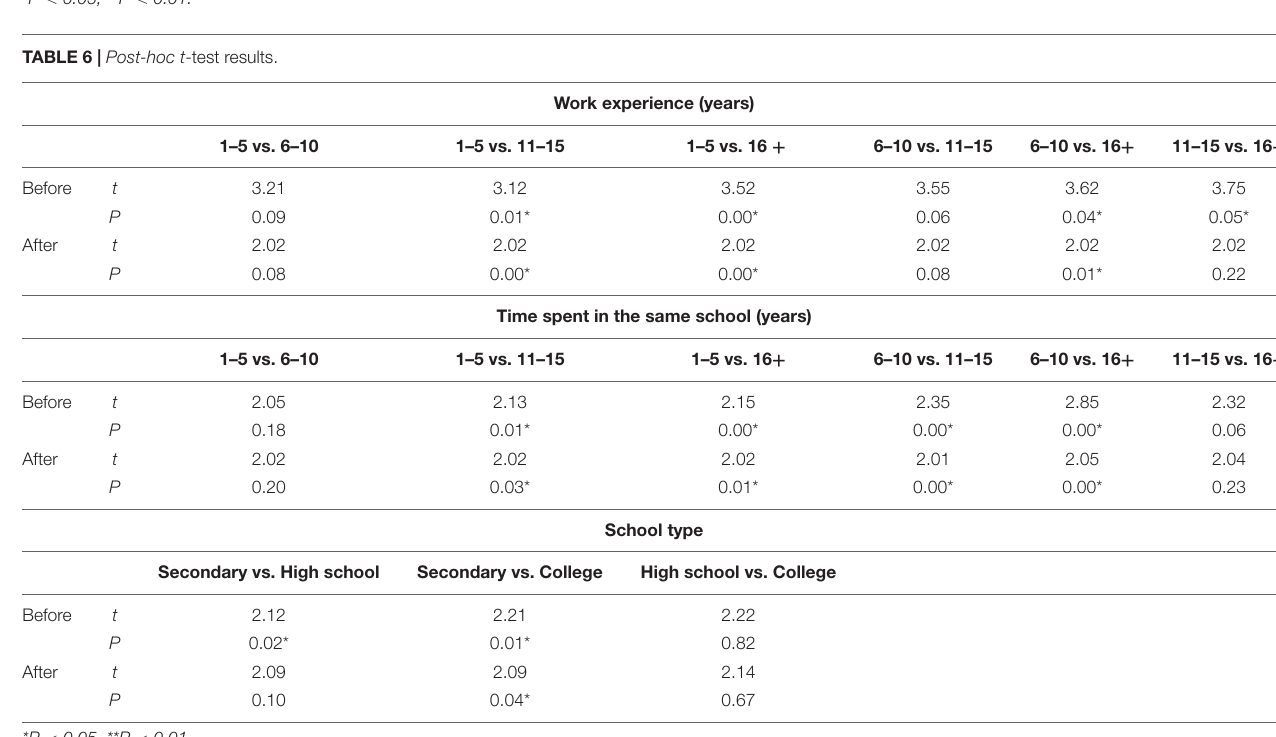
Masters Active at Passive at degree level Continuing Continuing Professional Professional Dev. Dev.